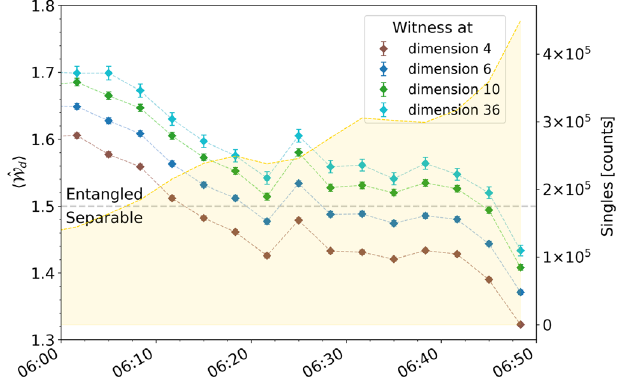
FIG. 2. Entanglement witness. Expectation values of entangle- ˆ W ment witness d of the discretized distributed state are plotted for different discretization dimensions d ¼ f 4 ; 6 ; 18 ; 36 g . Values above 1.5 certify entanglement [41]. The witness is evaluated for data obtained by integrating over 200 s blocks of time-tagged detector event streams, which corresponds to typical passage times of satellites [42]. To show the increasing noise from sunlight the received single-photon count rates at Bob ’ s side are plotted in the background. From the plot it is apparent that with sunrise the channel conditions start to deteriorate rapidly. Nevertheless, entanglement can be certified well up to 1.5 h after the sunrise ( 05 ∶ 03 ). Further, discretizations with higher dimen- sionality outperform the lower-dimensional ones in all cases.